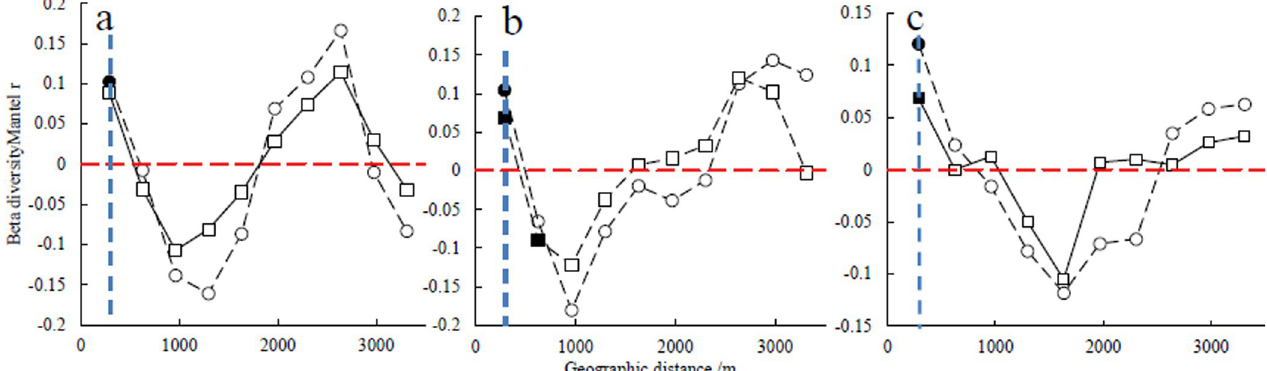
Fig 3. Spatial autocorrelation of beta diversity of different plant types: Trees (a), shrubs (b), and herbs (c). Note: The circles represent the spatial autocorrelation of β diversity, and the squares represent the spatial autocorrelation of β diversity after the addition of soil environmental factors. Solid circles or squares indicate significant spatial autocorrelation of β diversity (P < 0.05), while open circles or squares was not significant (P > 0.05). The blue vertical dotted line indicates a geographic distance of 288 m.